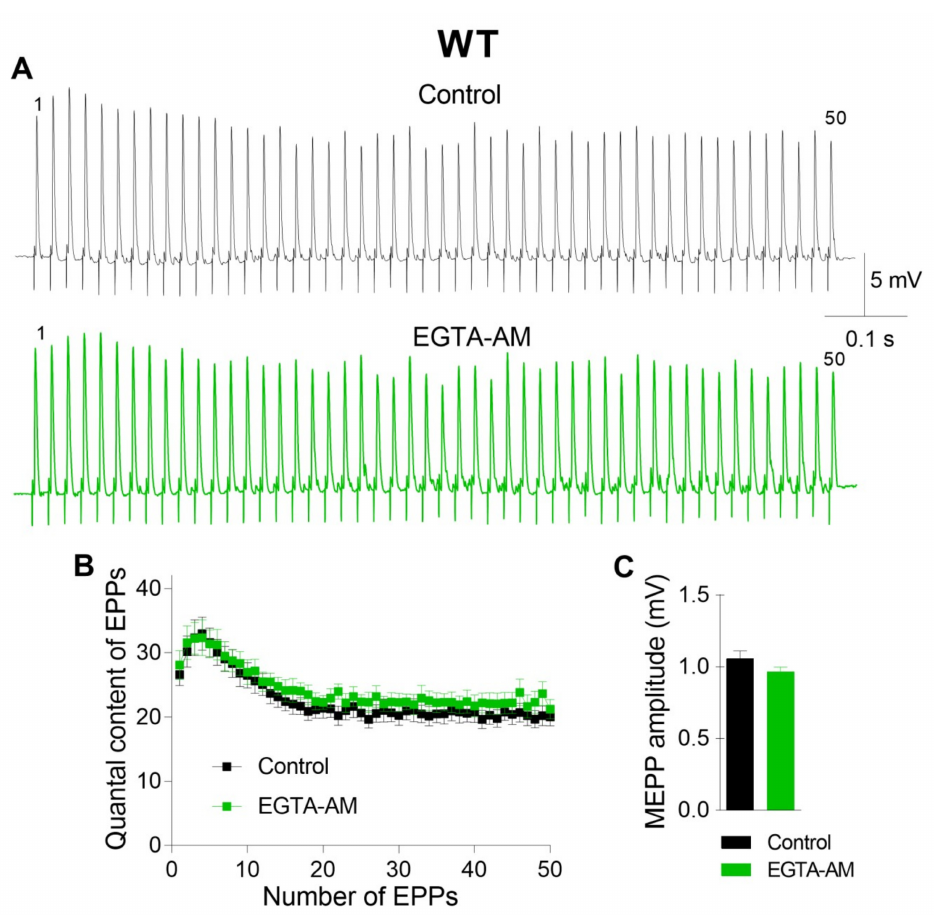
Figure 1. Incubation with the slow Ca 2 + chelator EGTA-AM (50 µ M) did not change evoked neuromuscular transmission at the neuromuscular junctions (NMJs) of wild-type (WT) mice during a short high-frequency train (50 Hz, 1 s). ( A ) Representative recordings of evoked end-plate potentials (EPPs) in the control group (top) and after incubation with EGTA-AM (bottom). ( B ) EPP quantal content in the control group (n = 22) and after incubation with EGTA-AM (n = 15). ( C ) Miniature end-plate potential (MEPP) amplitude in the control group and after incubation with EGTA-AM. The symbols, histograms and error bars represent the mean ±